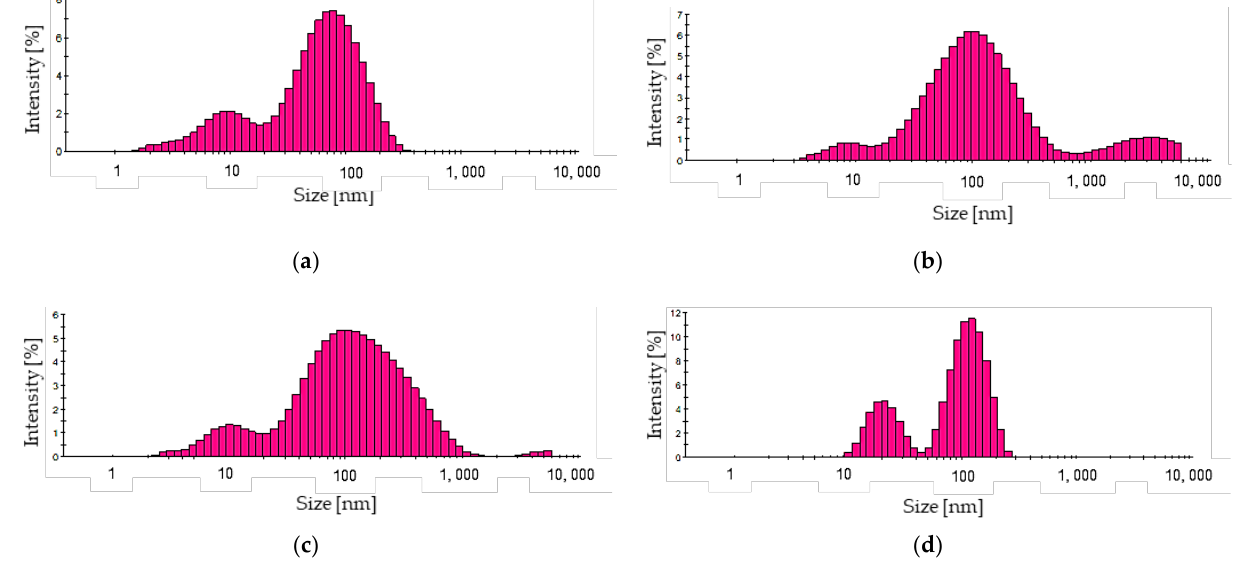
Figure 3. The size distribution of gold particles obtained using 25 mL of 0.5% ( a ), 1.0% ( b ), 2.0% ( c ) and 3% ( d ) Arabic gum solution.